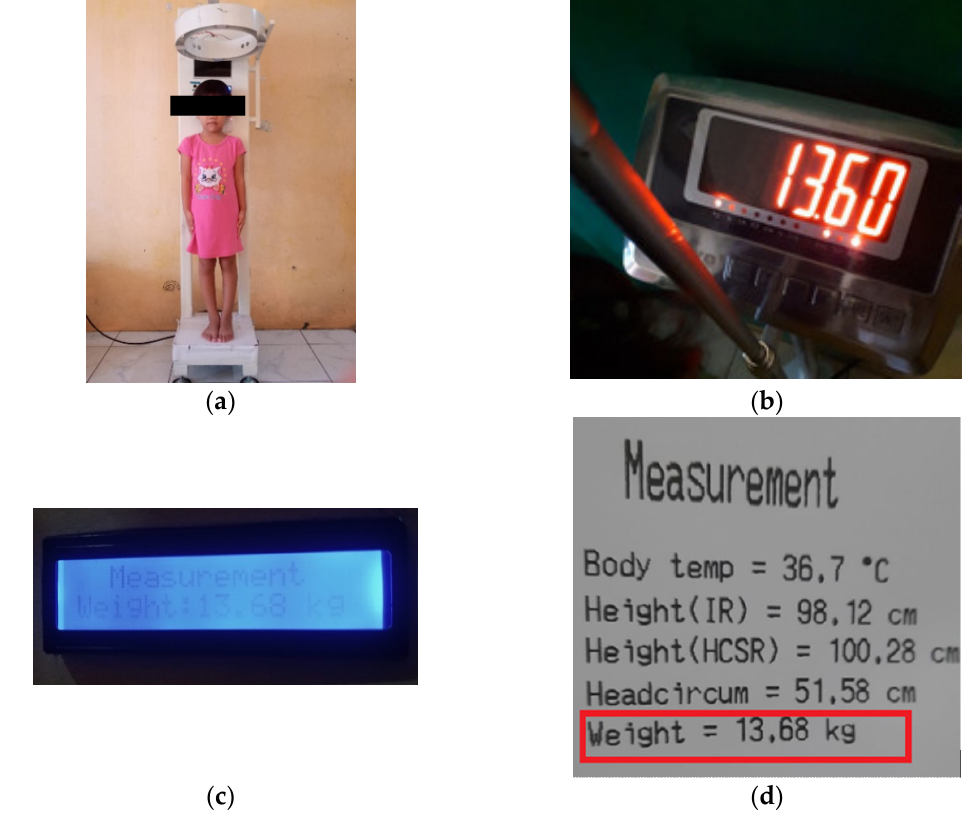
Figure 14. Body mass measurement test: ( a ) using the commercial device; ( b ) using anthropometric prototype; ( c ) display of body mass measurement on the LCD 6 × 2; and ( d ) printer output. The results of measuring body mass using conventional tools and prototype of the anthropometric system are shown in Table 5. The average error in this test is Table 5. Comparison between body mass measurement results using conventional tools (floor scale) and a prototype of an anthropometric system.